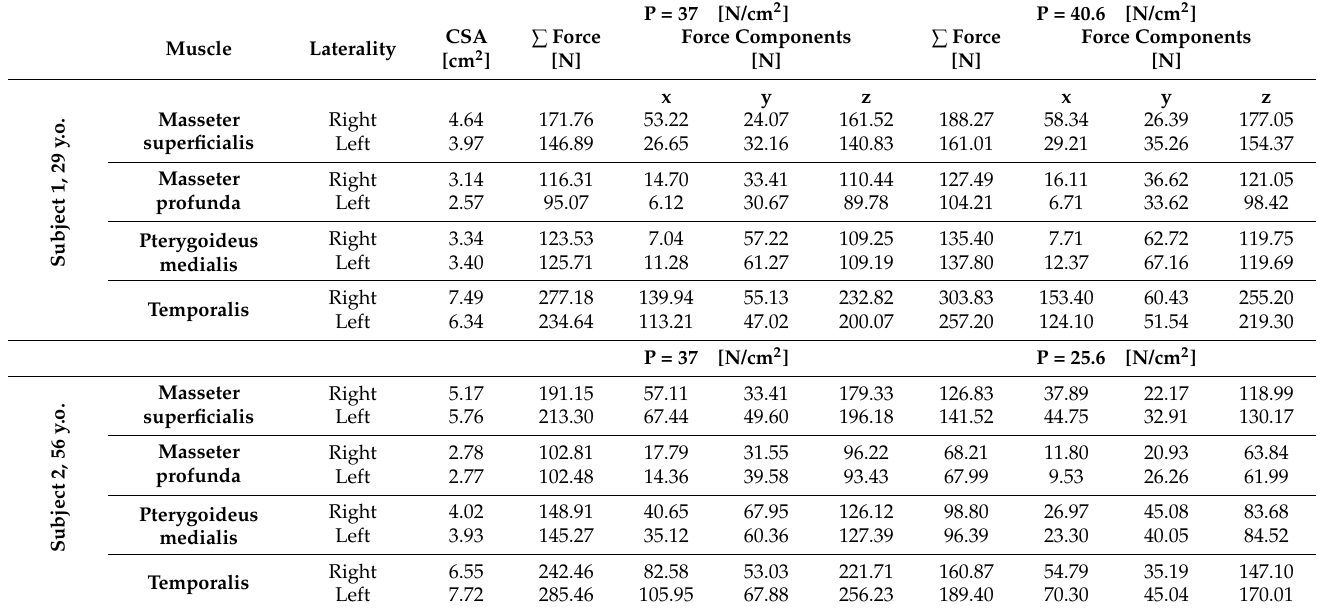
Table 2. Both subjects’ muscle force vector components for the literature-based intrinsic strength value (P = 37) and the determined patient-specific intrinsic strength values (P = 40.6 and P = 25.6). P = 37 [N/cm 2